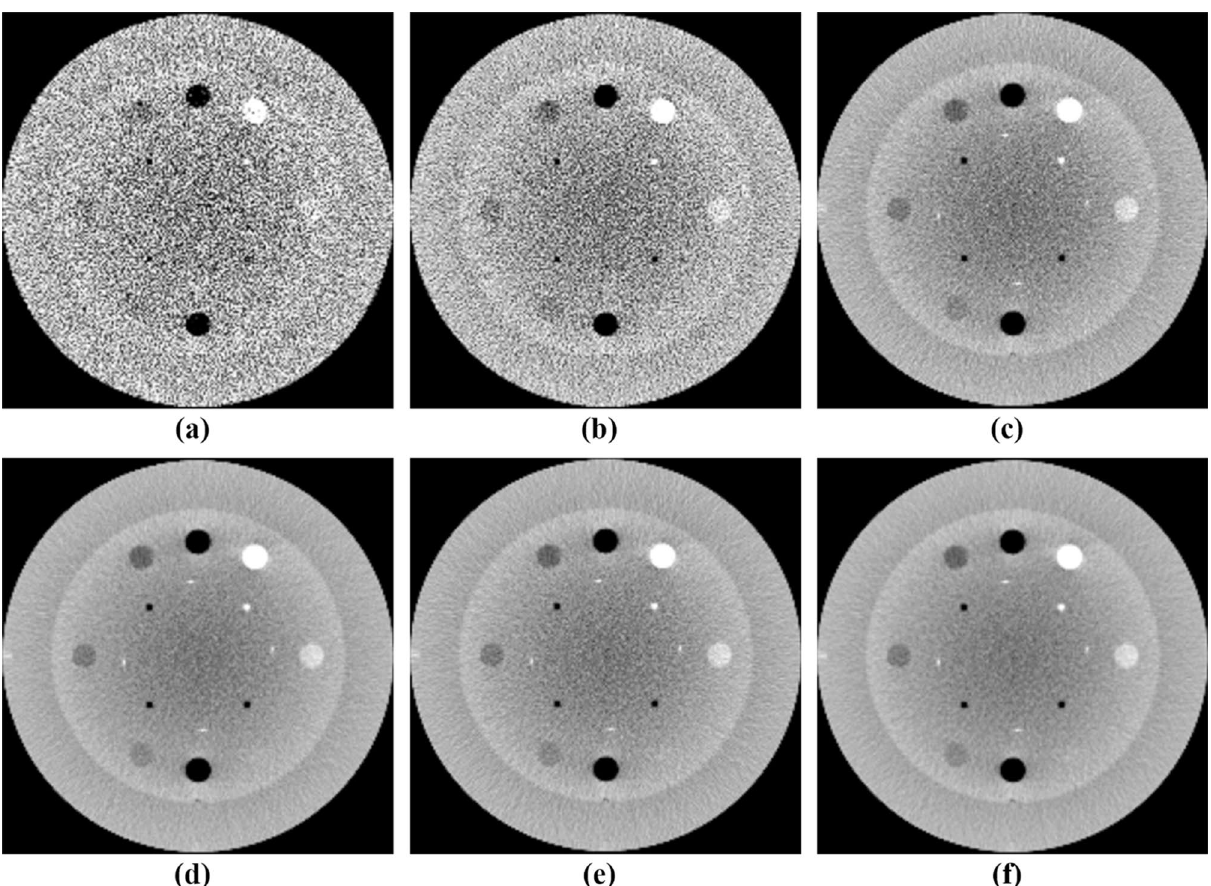
Figure 6. Comparison between the same views of the low resolution reconstruction image generated by applying FDK with ( a ) SL, ( b ) ATV, ( c ) NLTV, ( d ) SL + cubic B-spline, ( e ) ATV + cubic B-spline, and ( f ) NLTV + cubic B-spline using the Catphan503 phantom. These images are displayed at window (width and level) settings of (975, 0) HU.